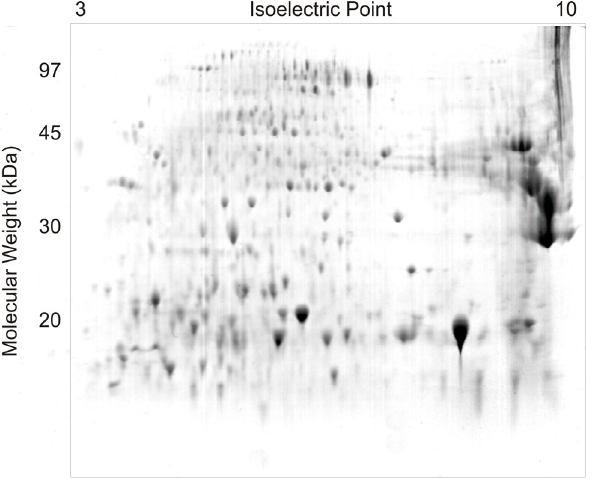
Figure 2. Two-dimensional SDS-PAGE of Polybia paulista wasp venom by Santos et al. (44). The proteins of this venom were separated based on two biochemical properties: charge and molecular